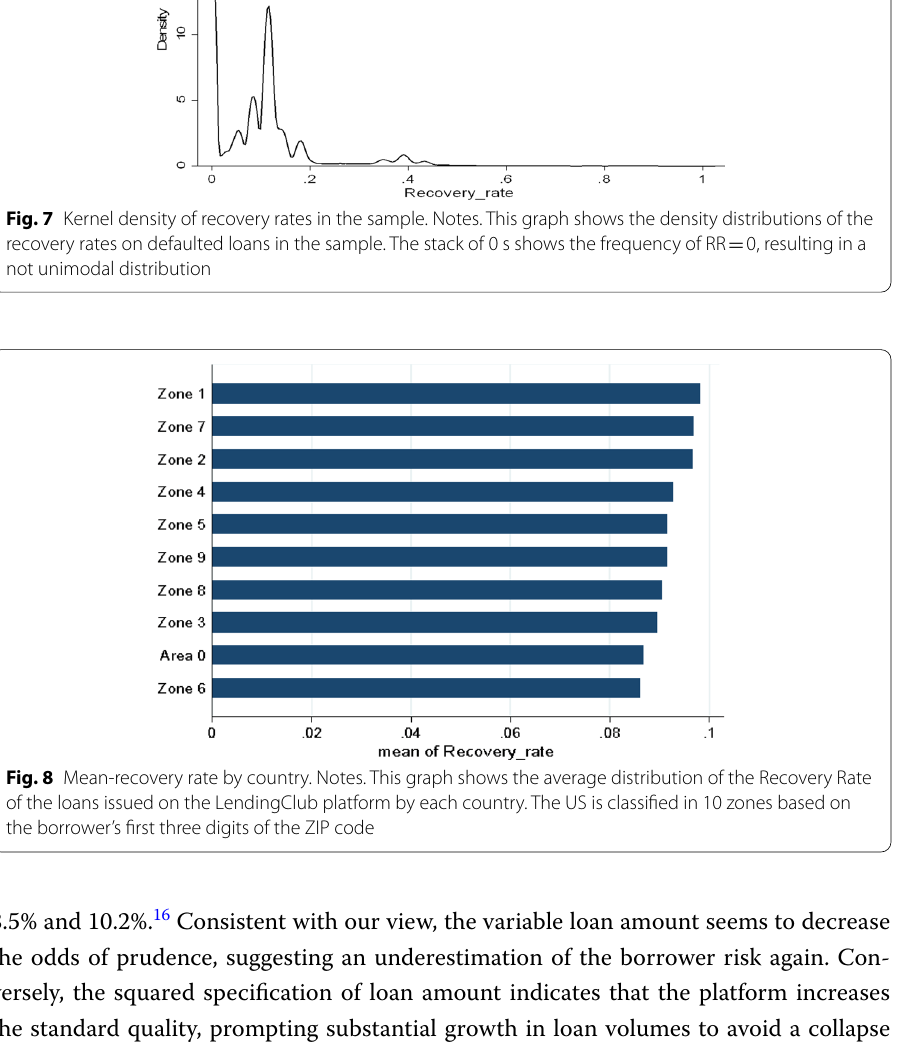
0, resulting in a =